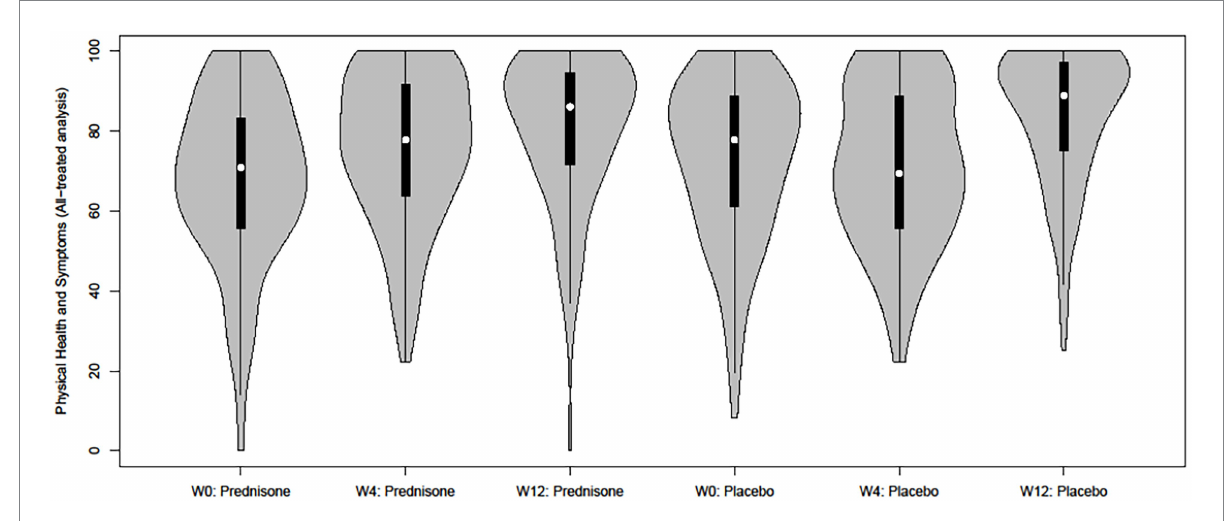
FIGURE 2 Grouped violin plot of the Physical Health and Symptoms score per intervention arm and time point (all patients